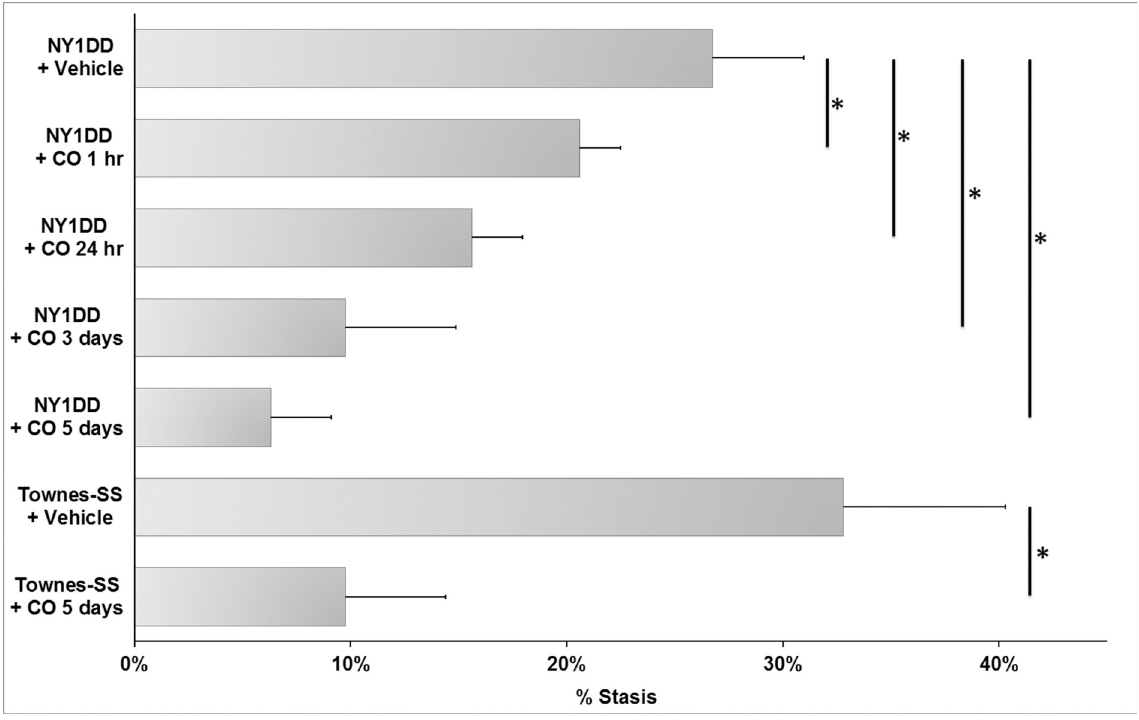
Fig 2. HBI-002 inhibits microvascular stasis. Microvascular stasis was measured in NY1DD and Townes-SS sickle mice (n = 3/bar) with implanted dorsal skin-fold chambers after gavage (10 ml/kg) with CO (HBI-002) or vehicle at 1 h or 24 h before hypoxia (7% O 2 ) or once-daily for 3 or 5 days with the last CO treatment 1 h before hypoxia. NY1DD vehicle data from 1, 3 and 5 days were pooled (n = 9 mice). One h prior to hypoxia, flowing venules (20–25 venules/mouse) were selected in the chamber window using intravital microscopy and mapped. After selection of flowing venules, mice were placed in hypoxia for 1 h, and then returned to room air for 1 h (H/R). After H/R the same venules were re-examined for stasis (no flow) and % stasis was calculated. Bar values represent means + SD. � P < 0.01. Differences between NY1DD groups were analyzed by One Way ANOVA (Holm-Sidak method). Differences between Townes-SS treatment groups were analyzed by the Student’s t-test.